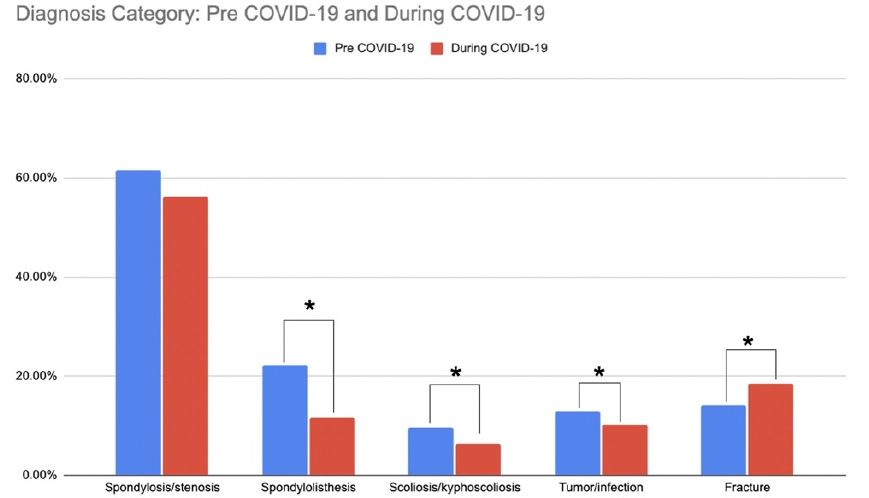
Figure 2. Diagnosis Category: Pre COVID-19 vs. During COVID-19. Significant group differences are Figure 2 . Diagnosis Category: Pre COVID-19 vs. During COVID-19 . Significant group differences indicated with asterisks are indicated with asterisks (*).